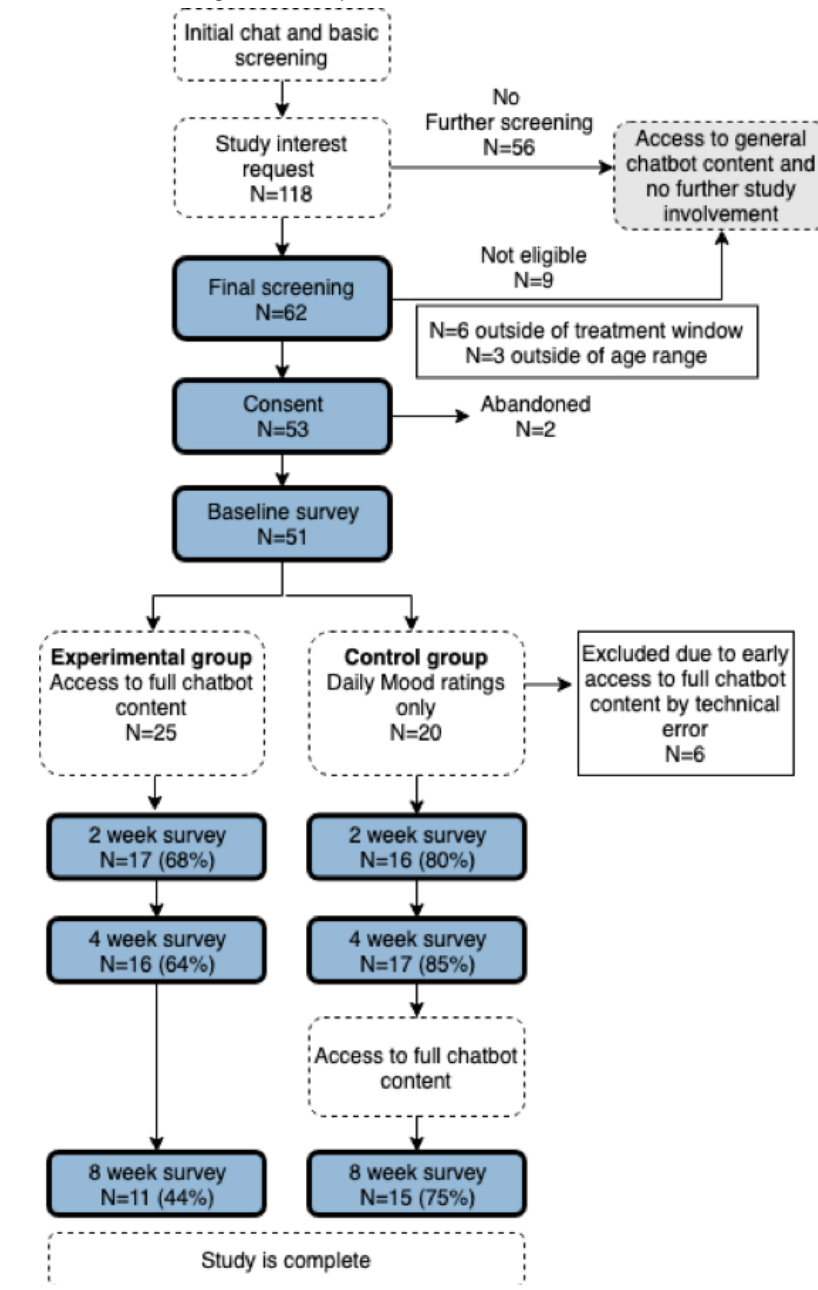
Figure 1. Participant recruitment and flow through the Vivibot pilot